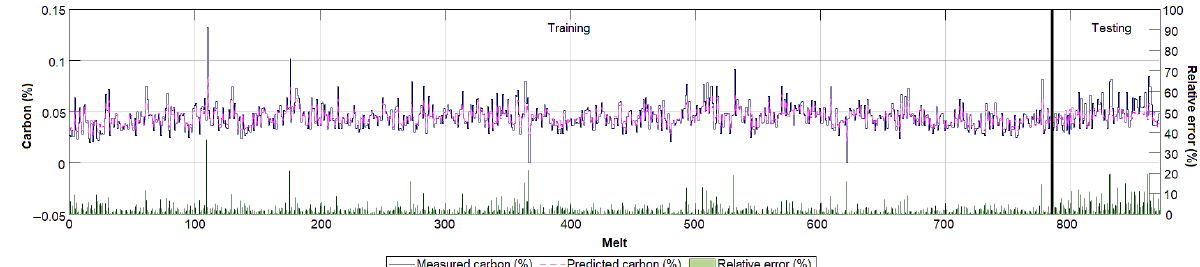
Figure 18. Prediction of endpoint carbon concentration in melt by RF model.